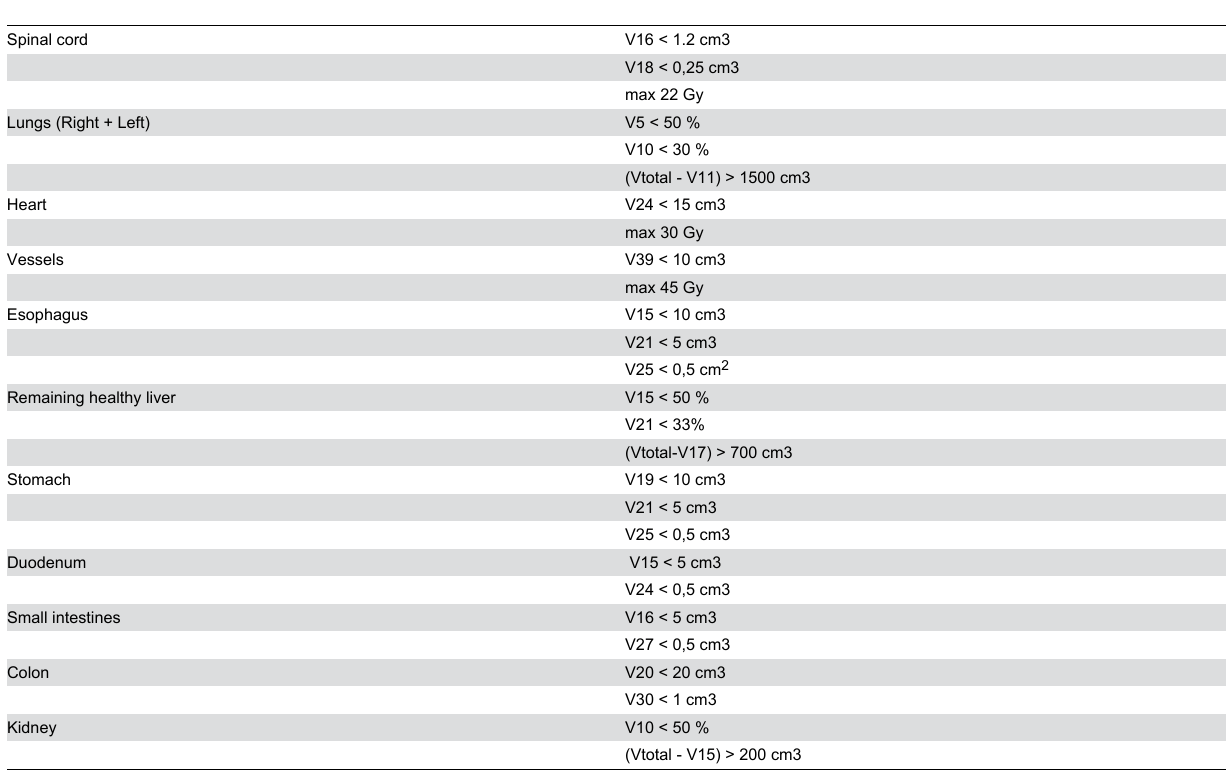
Table 1. Dose constraints for critical structures (treatment in three